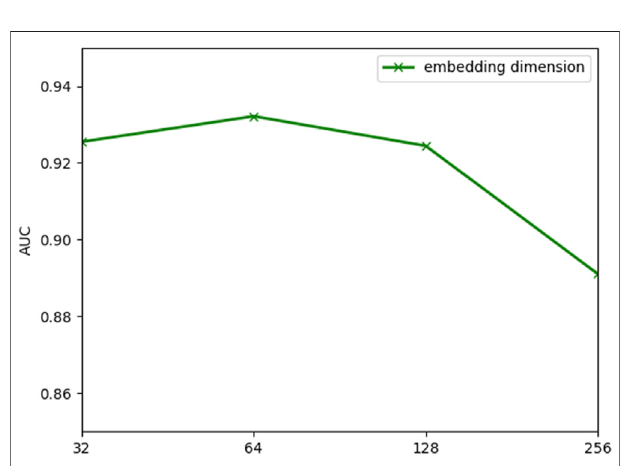
FIGURE 5 | Outcome of comparing various dropout rates and penalty